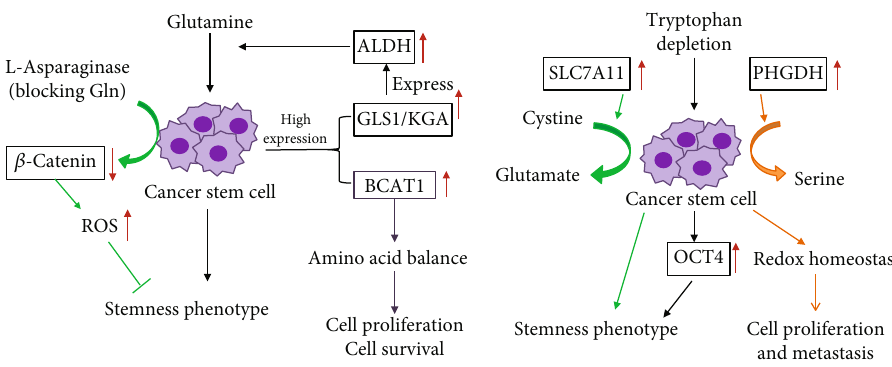
Figure 1: E ff ect of amino acids on the properties of cancer stem cells